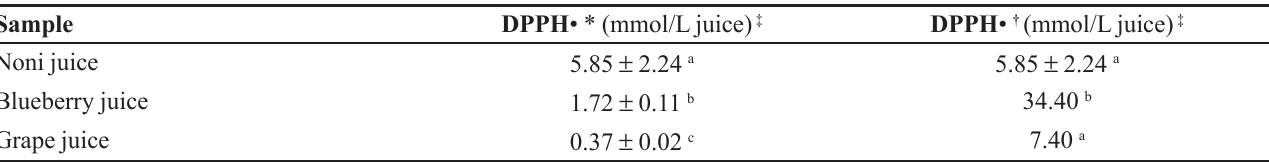
* DPPH •: 2,2-diphenyl-1-picrylhydrazyl. Antioxidant activity of commercial noni juice and of 5% diluted grape and blueberry juices. † DPPH •: Antioxidant activity of commercial juice noni, blueberry and grape concentrated juices. Different letters in the same column indicate significant difference (P>0.05). ‡ Results expressed in mMol/L